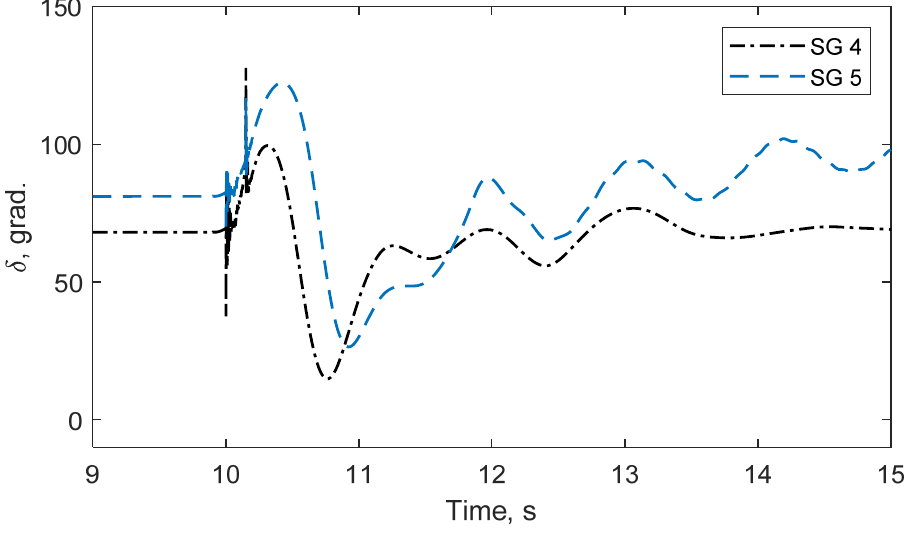
Figure 11. Load angles SG 4 and 5.